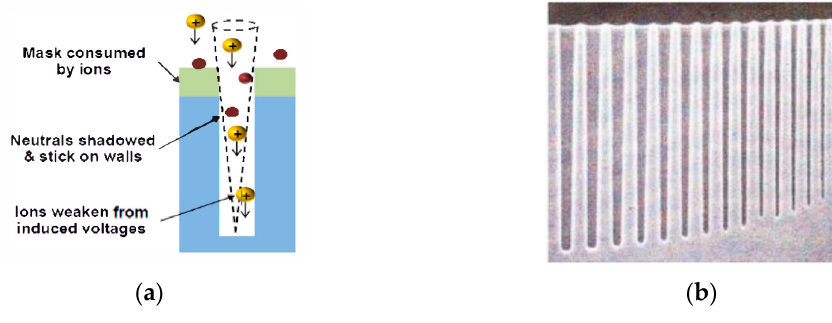
Figure 11. ( a ) Depth reduced Ion/Neutral flux ratio and ( b ) Opening CD size dominates the depth loading. Reproduced with permission from [121]. Copyright IEEE, 2015.